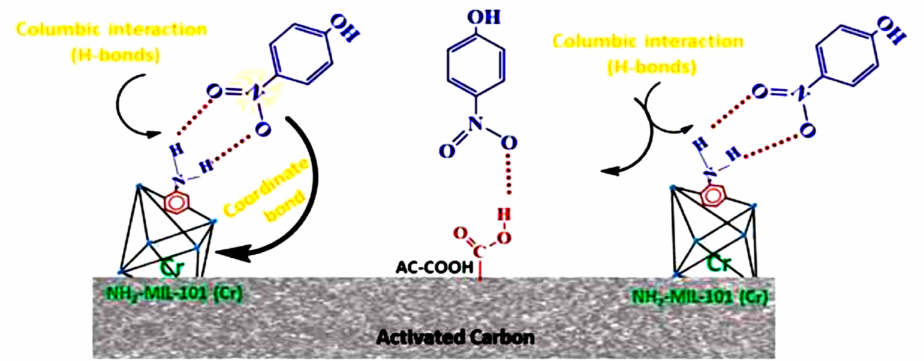
Figure 12. A possible adsorption mechanism of PNP on an AC-NH 2 -MIL-101(Cr) composite. Reprinted with permission from [307].